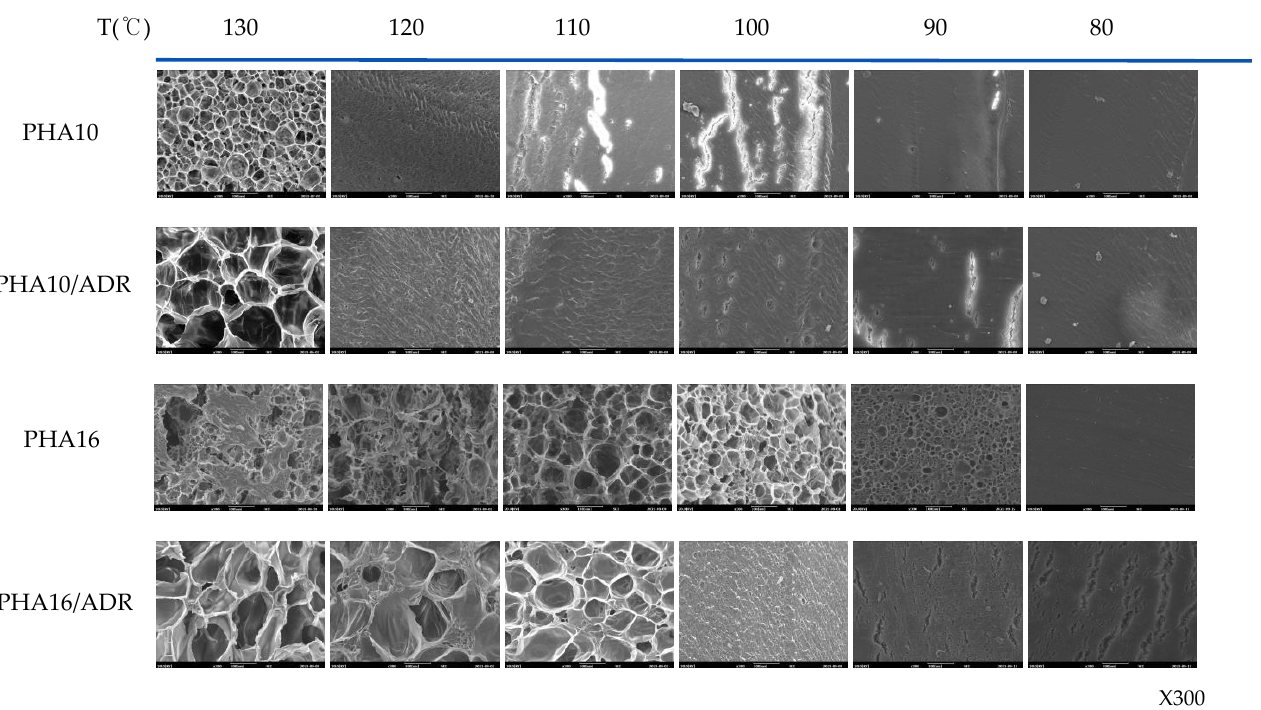
Figure 8. Effect of forming pressure on the structure of the P(3HB- co -4HB) foams. Foaming tempera- tures of P(3HB- co -10% 4HB), P(3HB- co -16% 4HB), and P(3HB- co -30% 4HB) are 130 ◦ C, 100 ◦ C, 50 ◦ C, respectively; ( a ) expansion ratio; ( b ) cell size; ( c ) cell density.